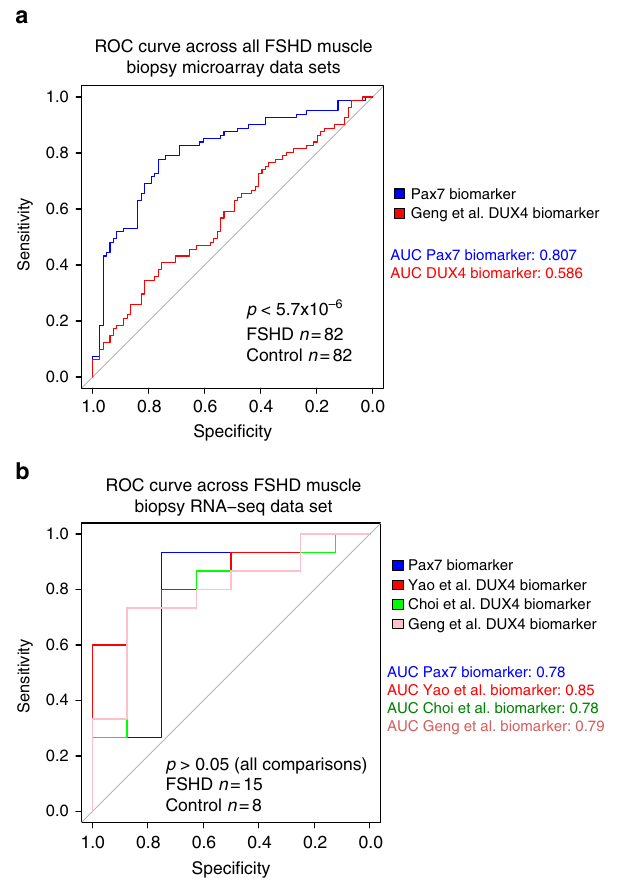
Fig. 4 PAX7 target gene repression is an equivalent FSHD biomarker to DUX4 target gene expression. a A ROC curve compares the discriminatory power of our PAX7 biomarker with the DUX4 target gene signature that we derived from Geng et al. 35 , across fi ve microarray data sets (in total n = 82 FSHD and n = 82 control muscle biopsies). De-Long ’ s test p- value is given and demonstrates that the PAX7 biomarker is a signi fi cantly better discriminator of FSHD status. b A ROC curve compares the discriminatory power of our PAX7 biomarker with the DUX4 target gene signatures that we derived from Geng et al. 35 and Choi et al. 34 and that described in Yao et al. 10 across the RNA-seq data set of n = 15 FSHD and n = 8 control muscle biopsies. De-Long ’ s test reveals no signi fi cant differences in the discriminatory power of these